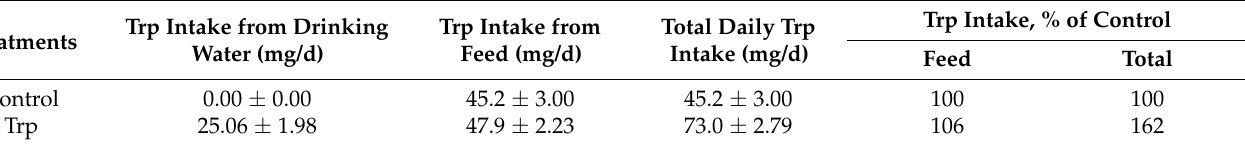
Table 1. Daily intake of tryptophan by rats in control and Trp groups before LPS treatment 1 . Trp Intake, % of Control Trp Intake from Drinking Trp Intake from Total Daily Trp Treatments Water (mg/d) Feed (mg/d) Intake (mg/d) Feed Total Control 0.00 ± 0.00 Trp 25.06 ±